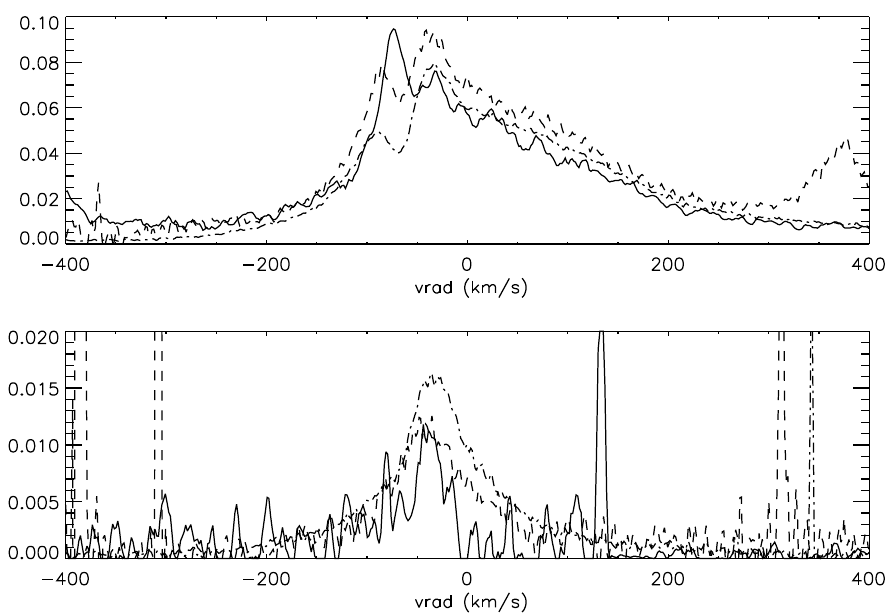
Fig. 8. The Balmer line profile in the symbiotic-like recurrent nova V407 Cyg on 2010 July 15 (top) and 2011 August 21 (bottom) (the date of the outburst is 2010 March 10) from the NOT (0.02 ˚A px (cid:0) 1 ). The profiles are H β (dot-dash), H γ (dash) and H δ (solid). The maximum shock velocity was > 3000 km s (cid:0) 1 . The stellar velocity is –54 km s (cid:0) 1 , note the wind absorption at an expansion velocity of about 10 km s (cid:0) 1 that becomes optically thin as the outburst progresses. The broad wings are due to a shock from the ejecta and subsequent outflow from the Mira (see discussion and Shore et al.